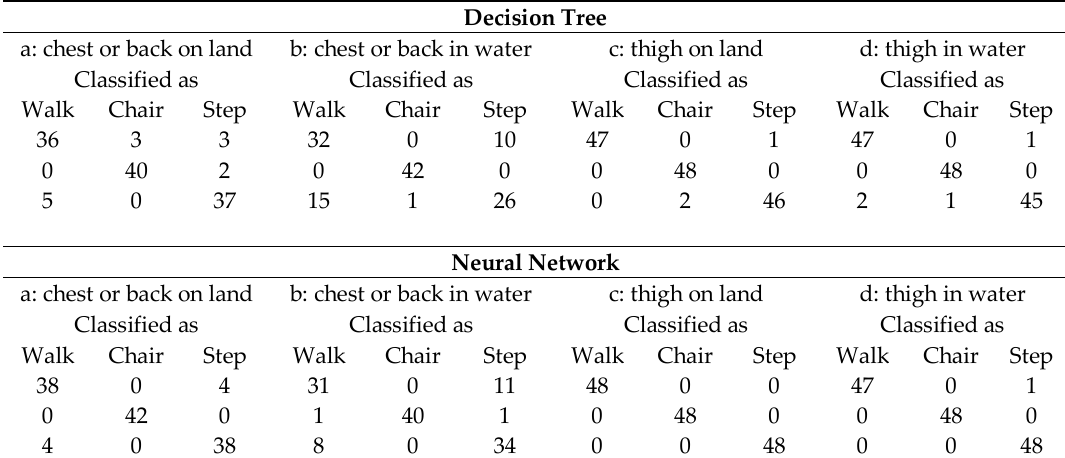
Table 1. The detail results of the decision tree and neural network